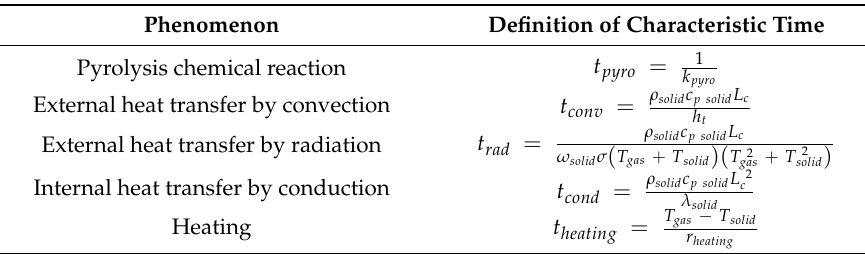
Table 3. Characteristic time definition for the pyrolysis of biomass.